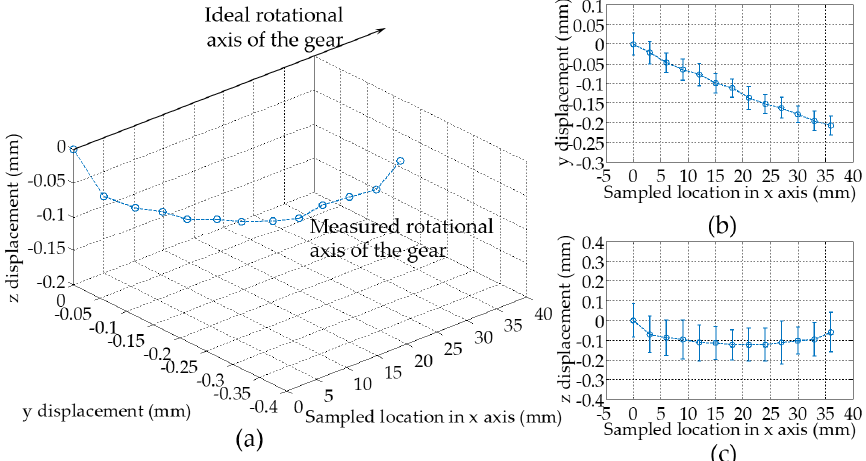
Figure 6. Measured horizontal and vertical gear axis displacement along the x 0 axis: ( a ) 3D view of the displacement variation; ( b ) Vertical displacement variation; and ( c ) Horizontal displacement variation. Note the error bars in ( b ) and ( c ) denote the minimum and maximum deviations of the measurement over 5000 samples based on the combined accuracy of the LTS and data acquisition system (DAQ) systems.